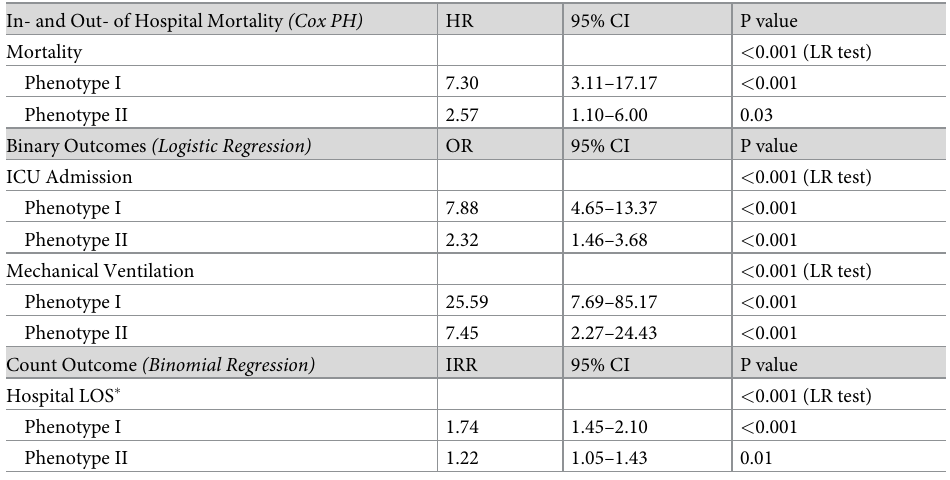
Table 2. Association of clinical phenotype with clinical